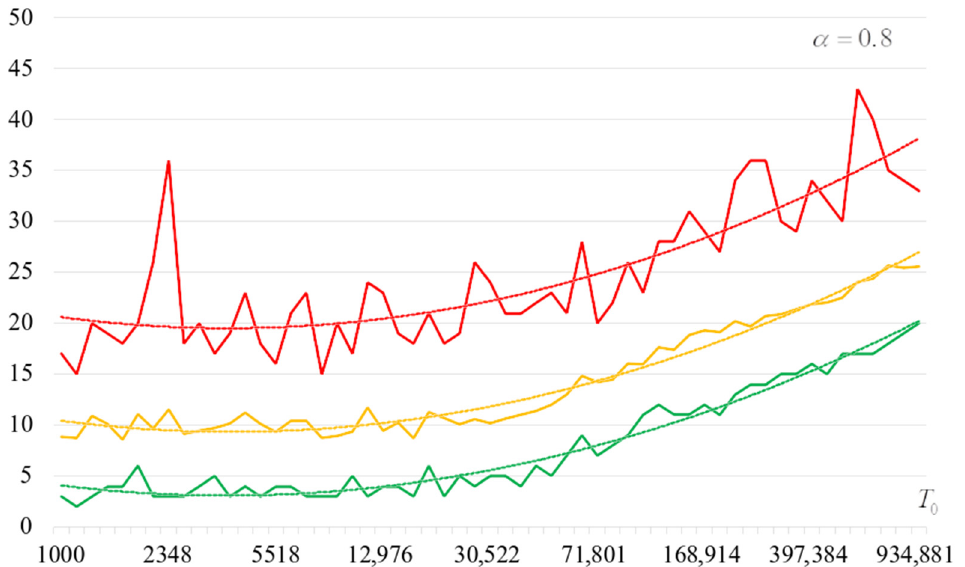
Figure 16. The dependencies of the number of iterations of the outer loop (until one of the criteria for stopping the algorithm is fulfilled) if the algorithm is successfully started, 𝛼 = 0.8 .